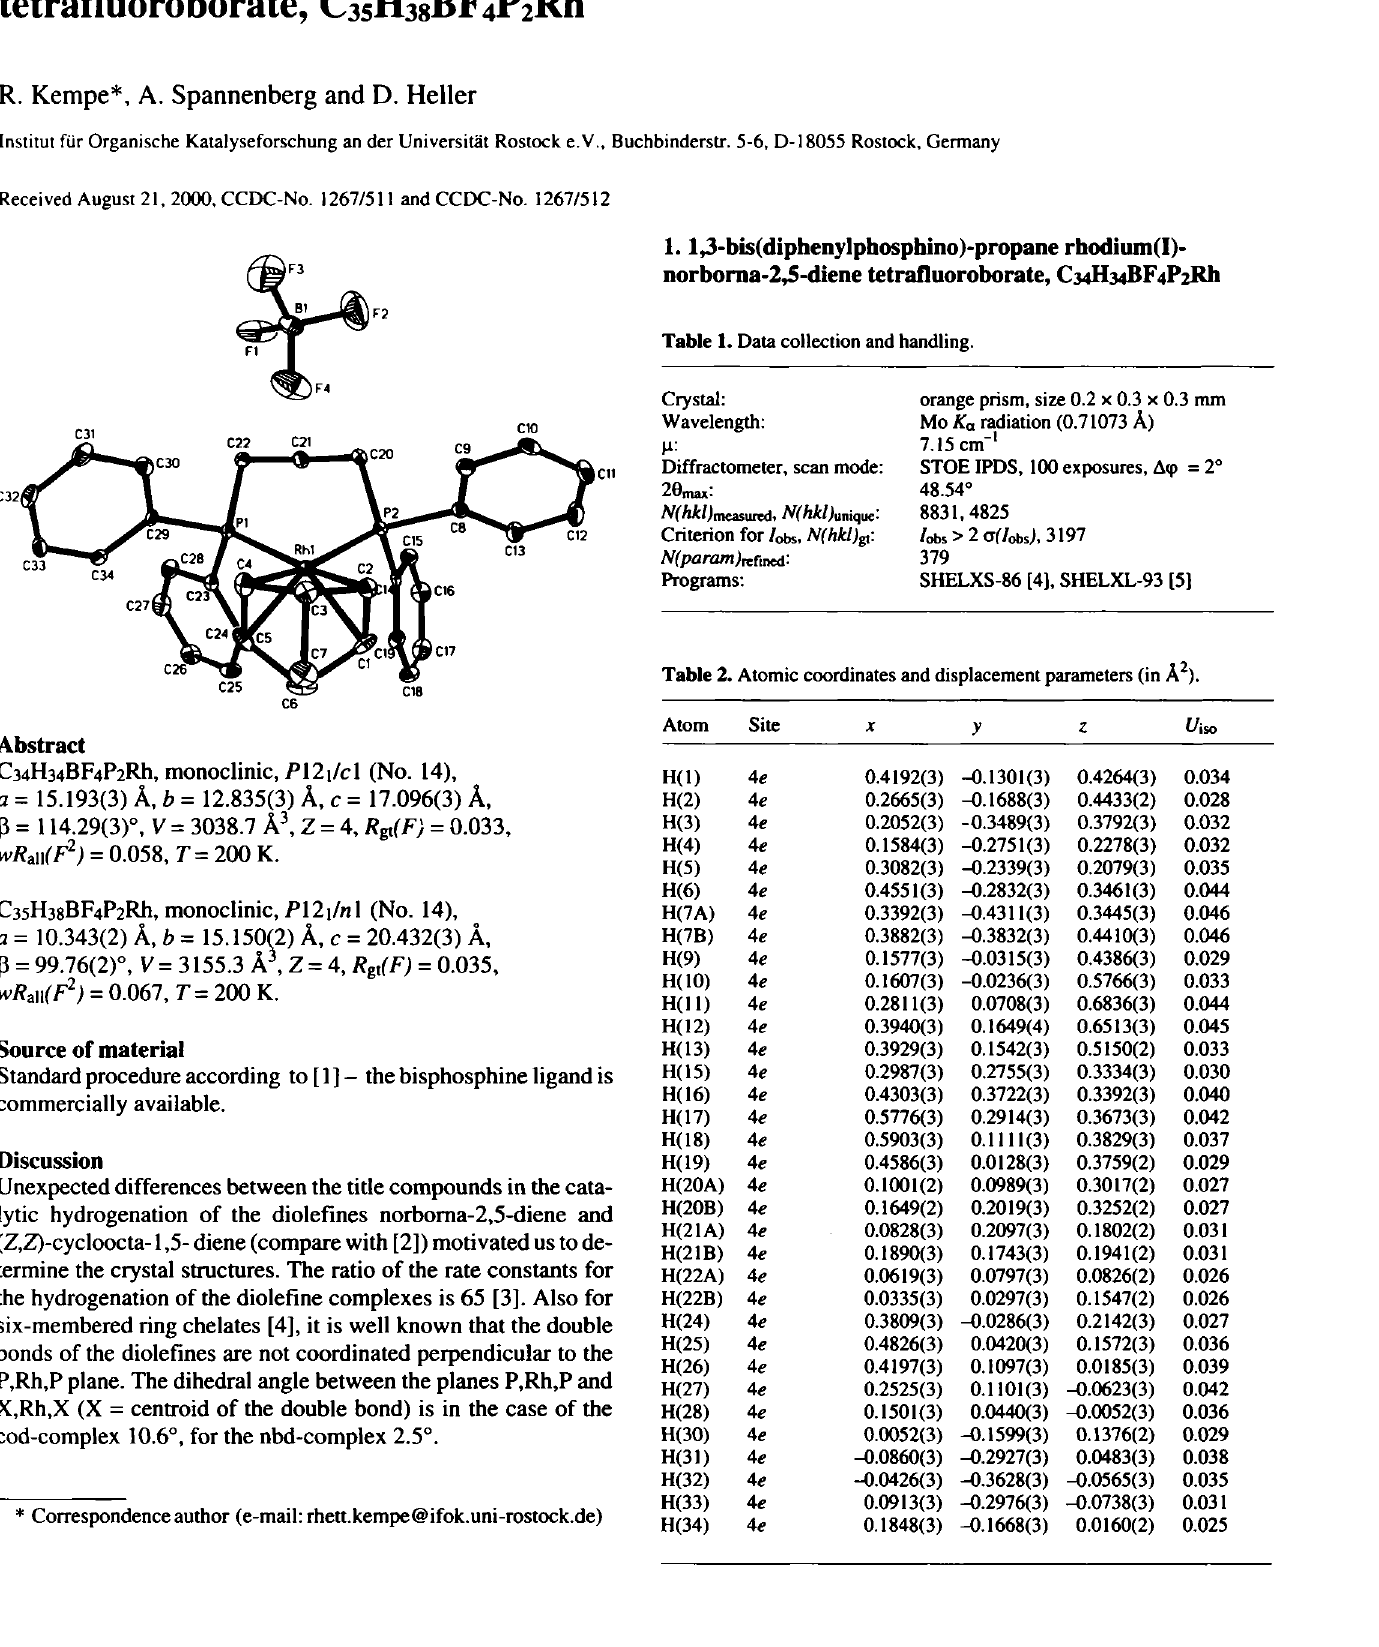
Table 1. Data collection and handling.